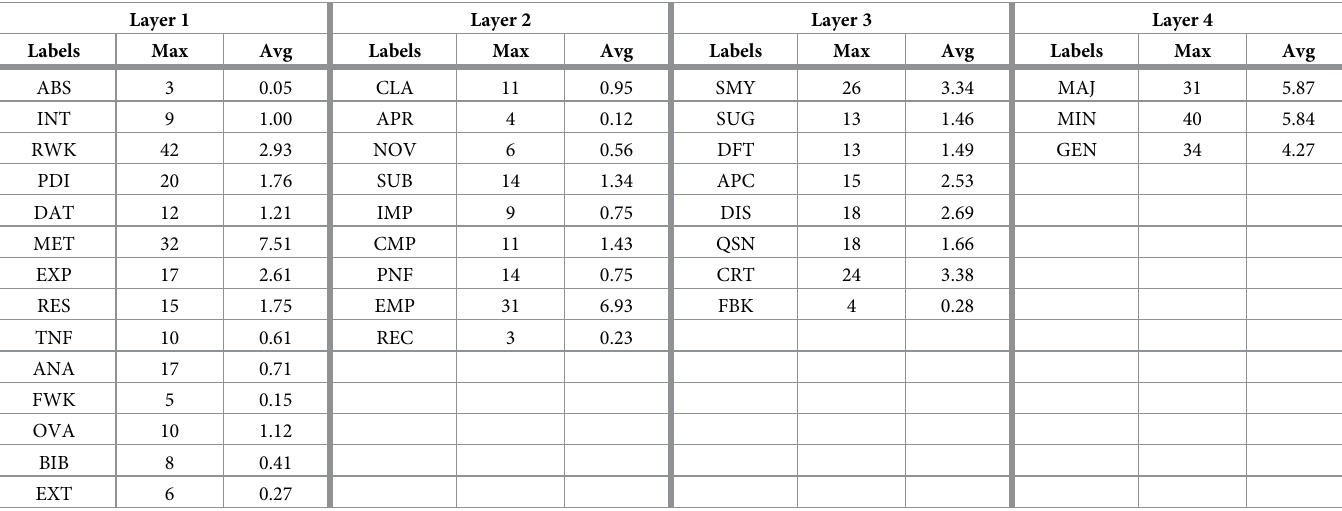
Table 4. Max and Avg occurrence of review statements in a review pertaining to the four different layers in the dataset (Min occurrence is zero for each label). Layer